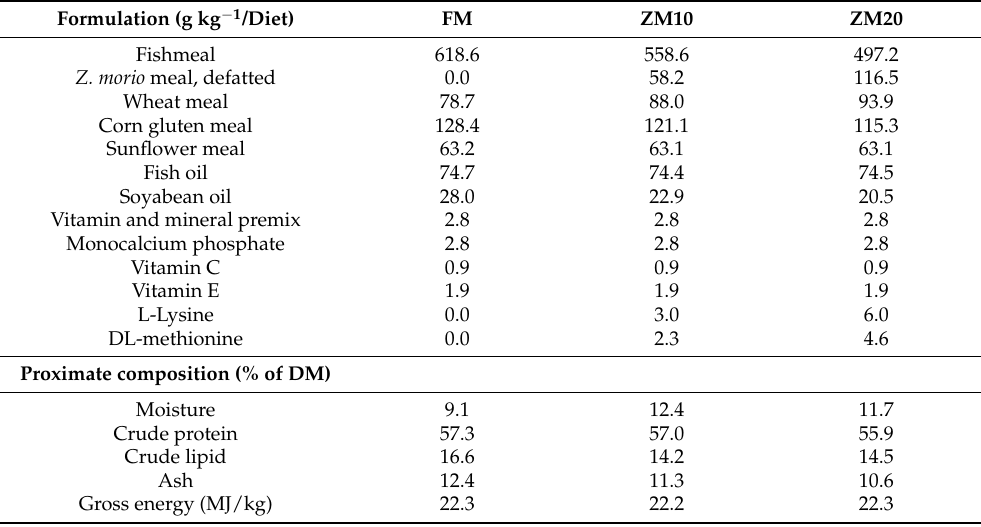
Table 1. Formulation (g Kg − 1 ) and proximate composition (% of DM) of the fishmeal diet (FM) and of the diets where fishmeal was replaced by 10% (ZM10) and 20% (ZM20) defatted Z. morio meal. Formulation (g kg − 1